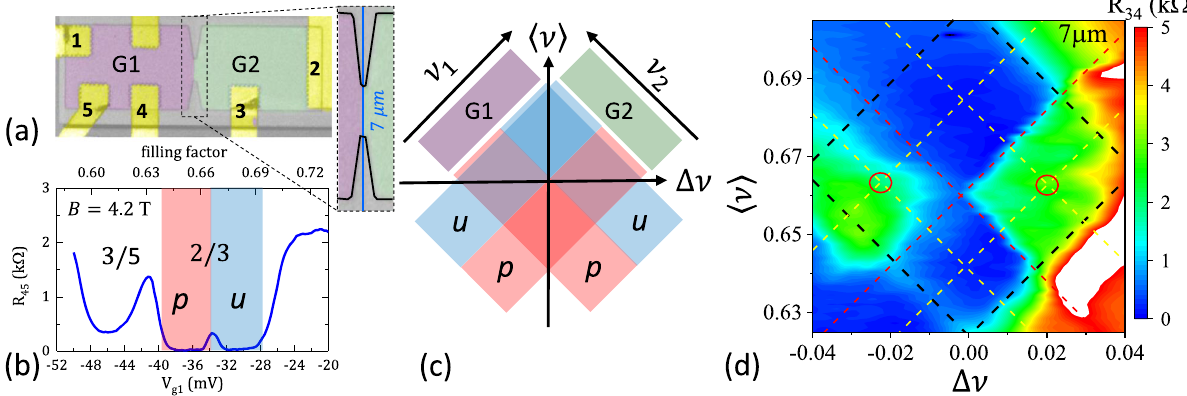
Fig. 1 Formation of helical domain walls at ν = 2/3. a A false-color image of a typical device. Yellow regions are ohmic contacts, 2D gas in green and magenta regions is controlled by gates G1 and G2, in the gray area, 2D gas is removed. In the enlarged section, thick black lines outline the mesa boundary and a vertical blue line marks a physical boundary between G1 and G2. b Magnetoresistance R 45 = ( V 5 − V 4 )/ I of a 2D gas is plotted as a function of gate voltage (controlling fi lling factor ν ) at a fi xed B = 4.2 T. Small peak at − 34 mV is the phase transition between unpolarized ( u ) and polarized ( p ) ν = 2/3 FQHE liquids. c A diagram of u and p states as a function of ν 1 and ν 2 under gates G 1 and G 2; 〈 ν 〉 = ( ν 1 + ν 2 )/2 and Δ ν = ( ν 1 − ν 2 ). d Resistance R = ( V − V I across a 7 μ m-long gates boundary is plotted as a function of 〈 ν 〉 and Δ ν . The black square outlines the ν = 2/3 region, red lines mark u-p 34 4 3 )/ transitions and yellow lines mark centers of u and p